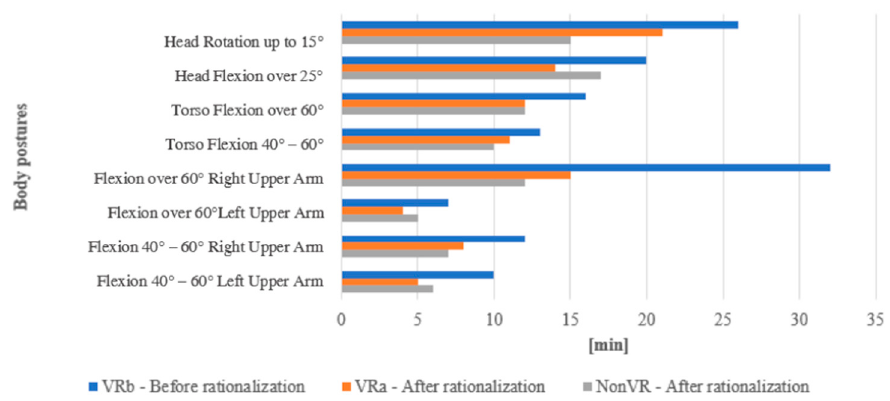
Figure 9. Measurement outliers for VRb, VRa, and NonVR .